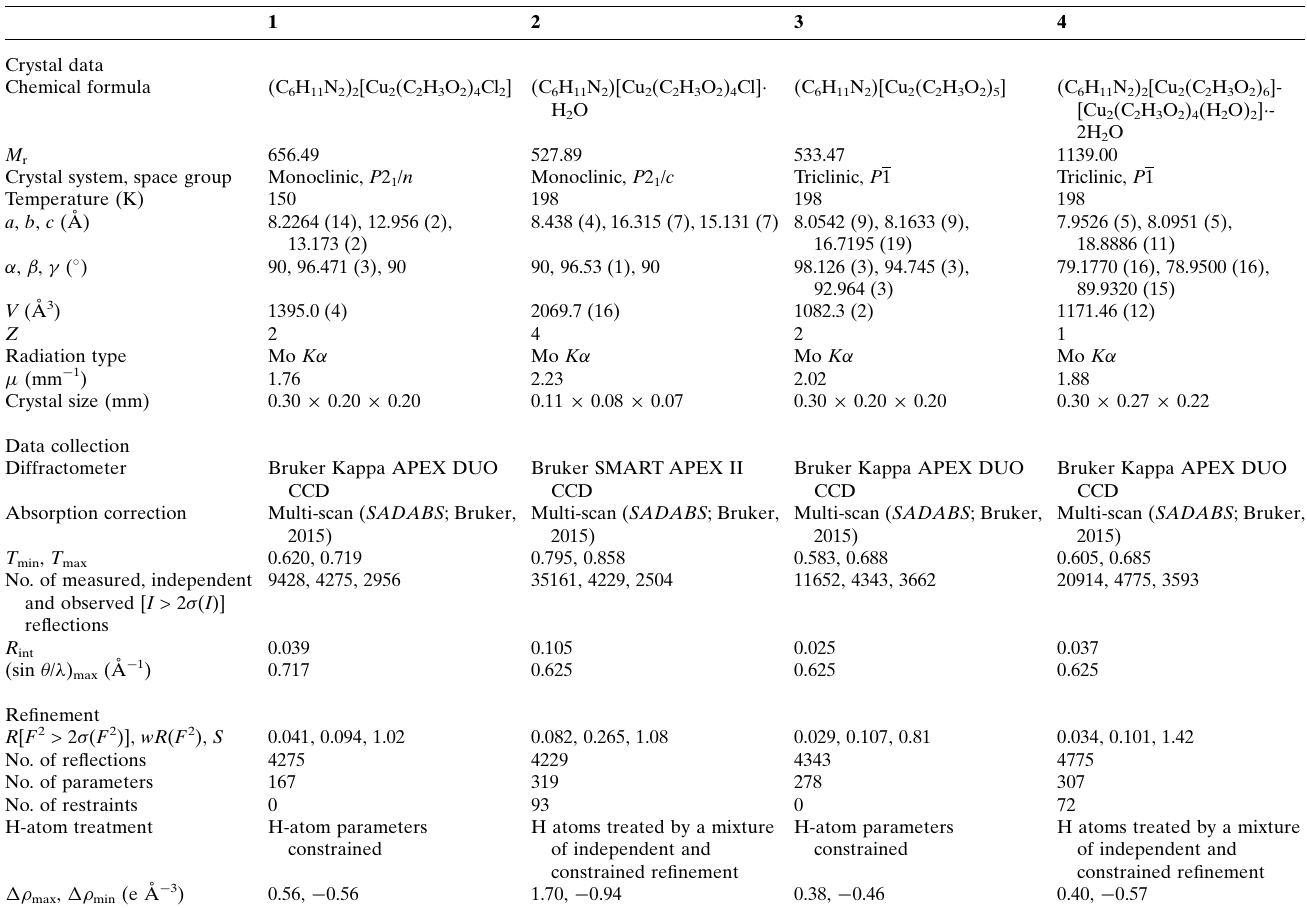
Table 6 Experimental details.